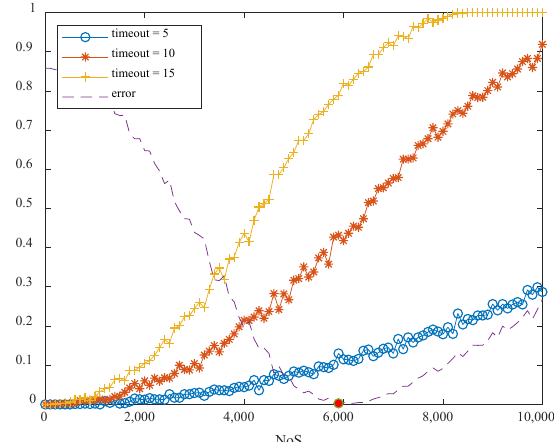
Figure 7. Simulation experiment results. (Nos means the number of forged packets sent by attackers per second).